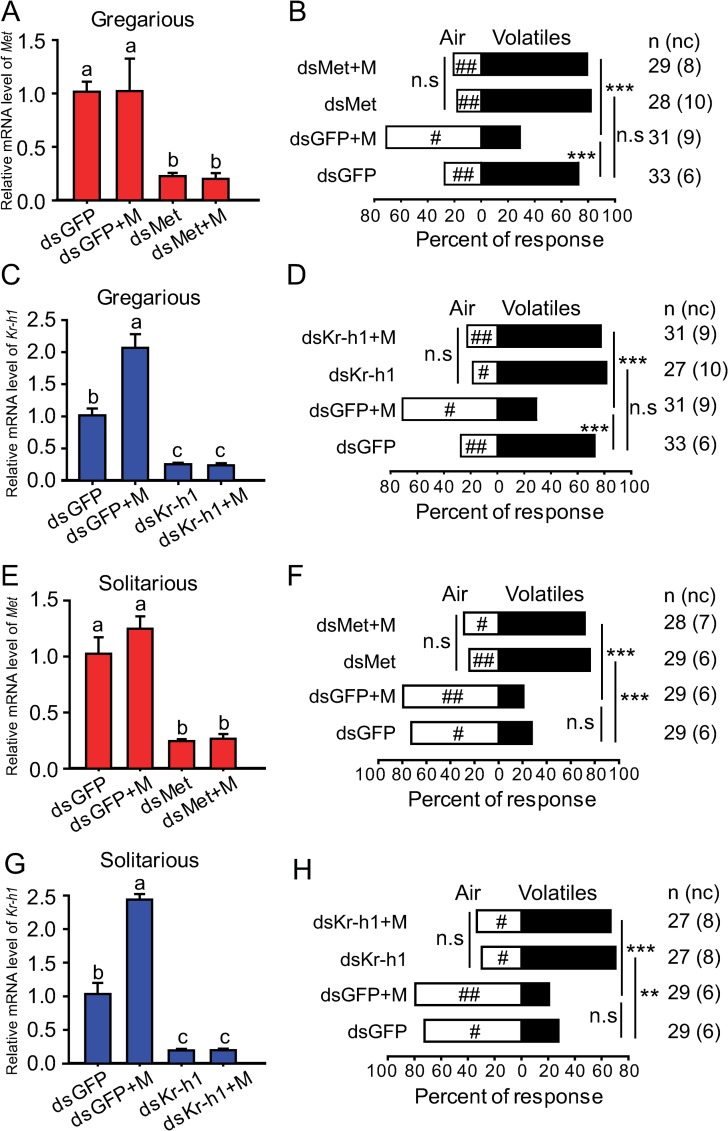
Effects of Met or Kr-h1 RNAi on antennal gene expression and choice behavior in gregarious and solitarious nymphs.(A and B) Relative mRNA level of Met gene and choice behavior after injection of dsGFP or dsMet or rescued by methoprene in gregarious nymphs. (C and D) Relative mRNA level of Kr-h1 gene and choice behavior after injection of dsGFP or dsKr-h1 or rescued by methoprene in gregarious nymphs. (E and F) Relative mRNA level of Met gene and choice behavior after injection of dsGFP or dsMet or rescued by methoprene in solitarious nymphs. (G and H) Relative mRNA level of Kr-h1 gene and choice behavior after injection of dsGFP or dsKr-h1 or rescued by methoprene in solitarious nymphs.